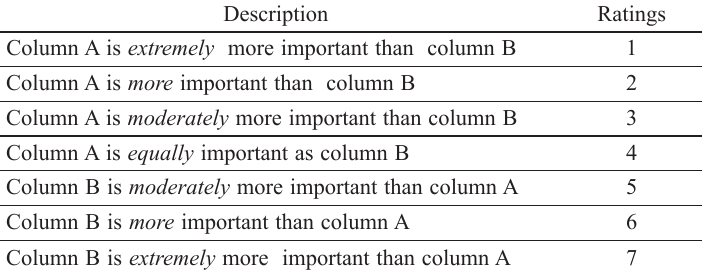
Table 2. Comparison categories and their